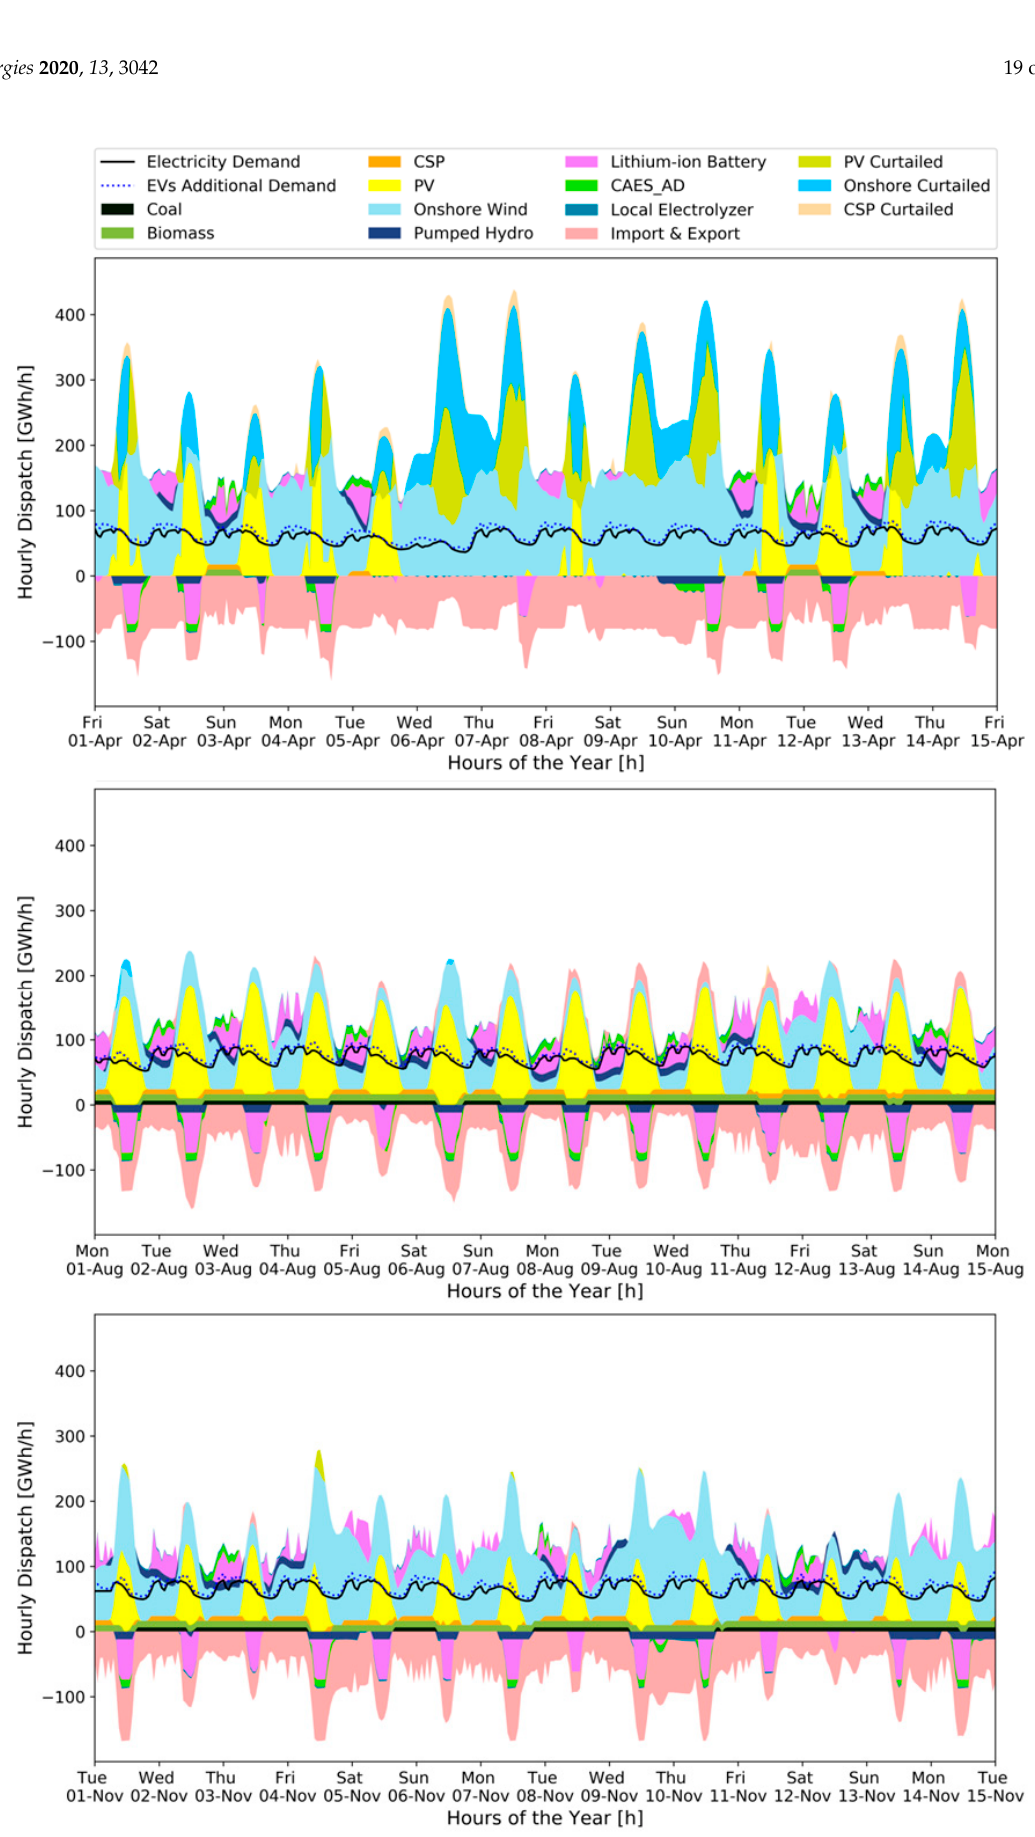
Figure 14. Typical hourly generation by technology, export and charge (-), import & discharge ( + ) to meet power demand in Inner Mongolia of April, August and November 2050.